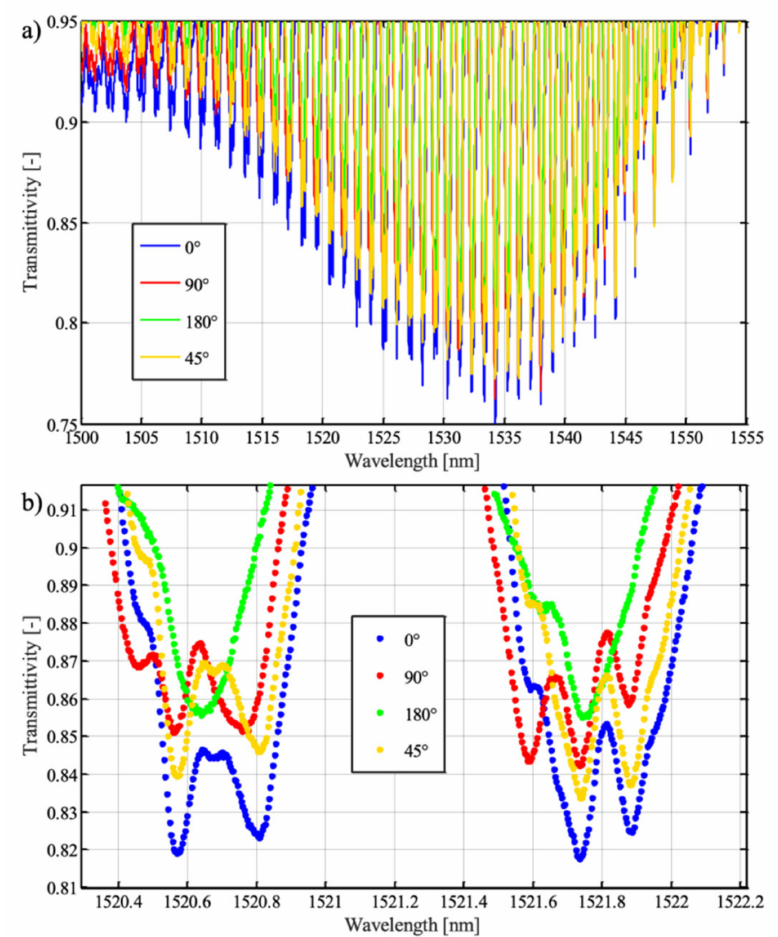
Figure 10. Comparison of the spectral characteristics of four TTFBG structures differing in the φ angle: ( a ) the entire spectral range, ( b ) a selected spectral range corresponding to two selected cladding